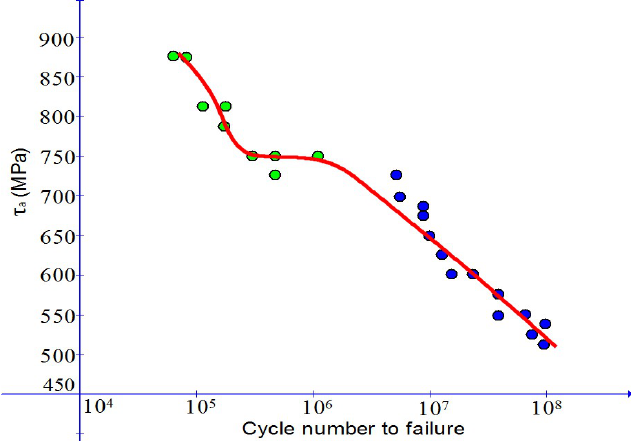
Figure 14. Comparison of simulation results with data (dots) from Mohd et al. [25] with duplex features from low to high cycle fatigue